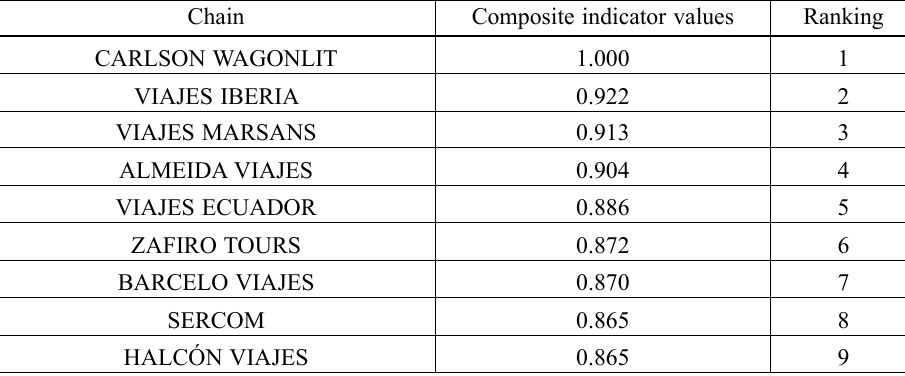
Table 4. Composite indicator with geometric aggregation: final values